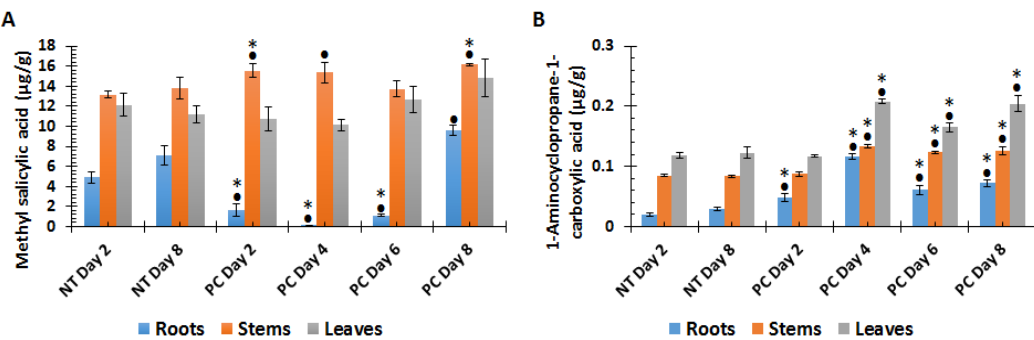
Figure 2. Changes in phytohormone levels in tomato plant tissues harvested at different time points following P. capsici (PC) inoculation in stems vs. non-treated (NT) plants. ( A ): Methyl salicylic acid and ( B ): 1-Aminocyclopropane-1-carboxylic acid. Extracts were prepared from 200 mg of pulverised tissue, and all concentrations are expressed as µg/g fresh weight (FW). An asterisk (*) or a dot (•) indicates the statistical significance with a p -value < 0.05 compared with the non-treated plants, with • indicating a comparison between NT day 2 and the PC infection on days 2–8 post- infection, and * a comparison between NT day 8 and the PC infection on days 2–8 post-infection. The results show a time-dependent differential reprogramming of MeSA and ACC in the various tissues.